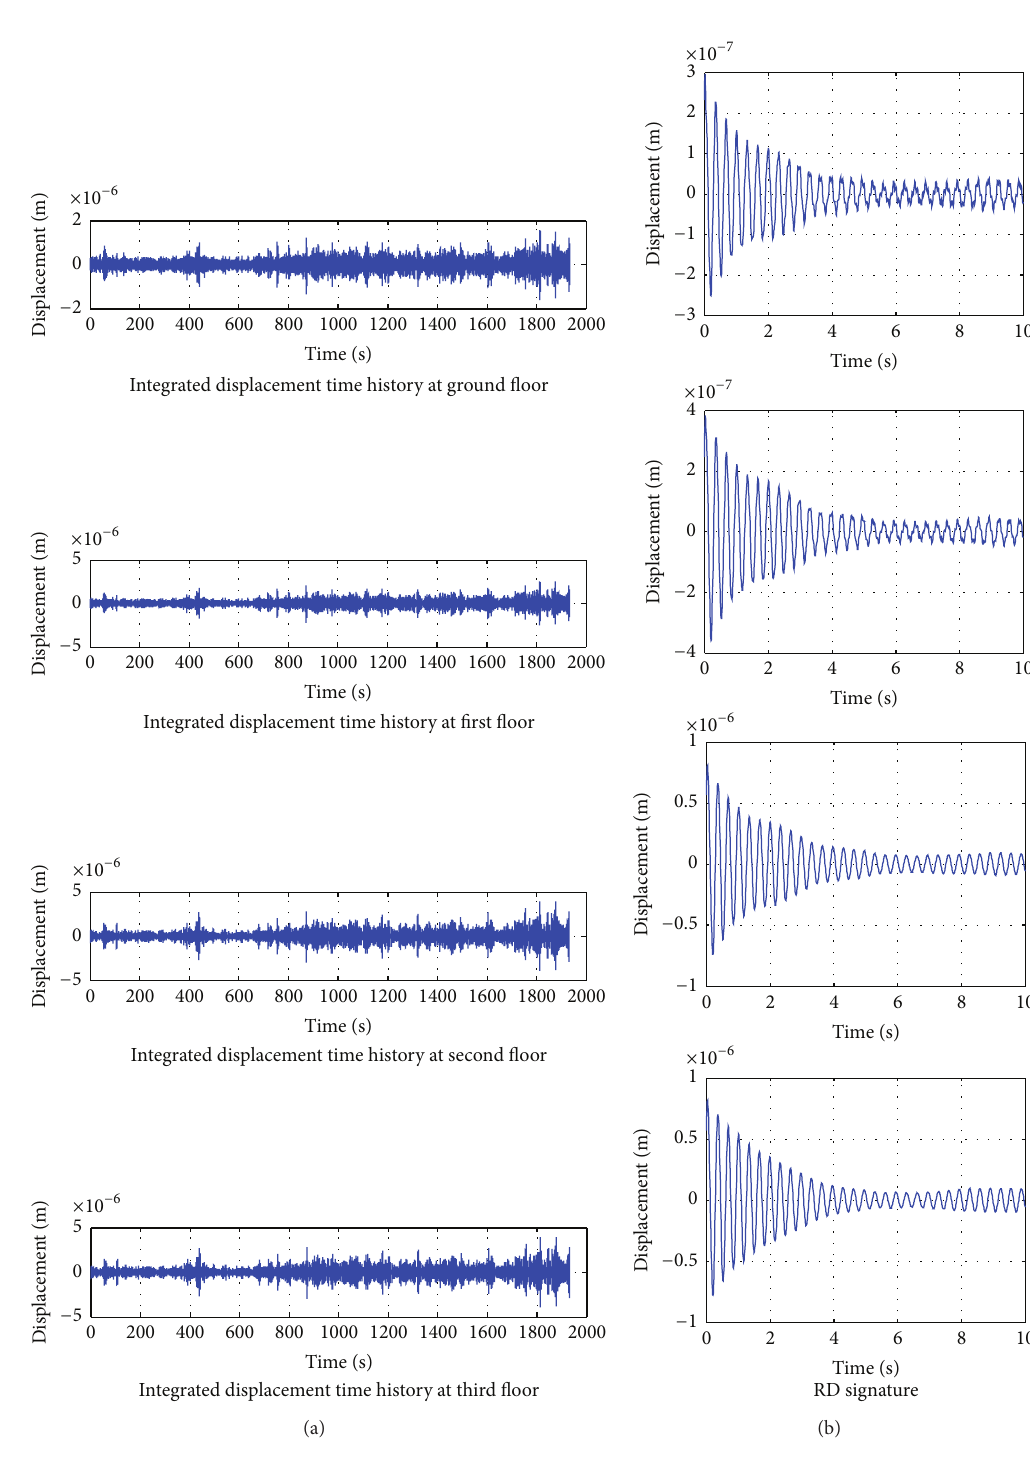
Figure 12: (a) Integrated displacement time histories at each floor in E-W direction and (b) their RD signature